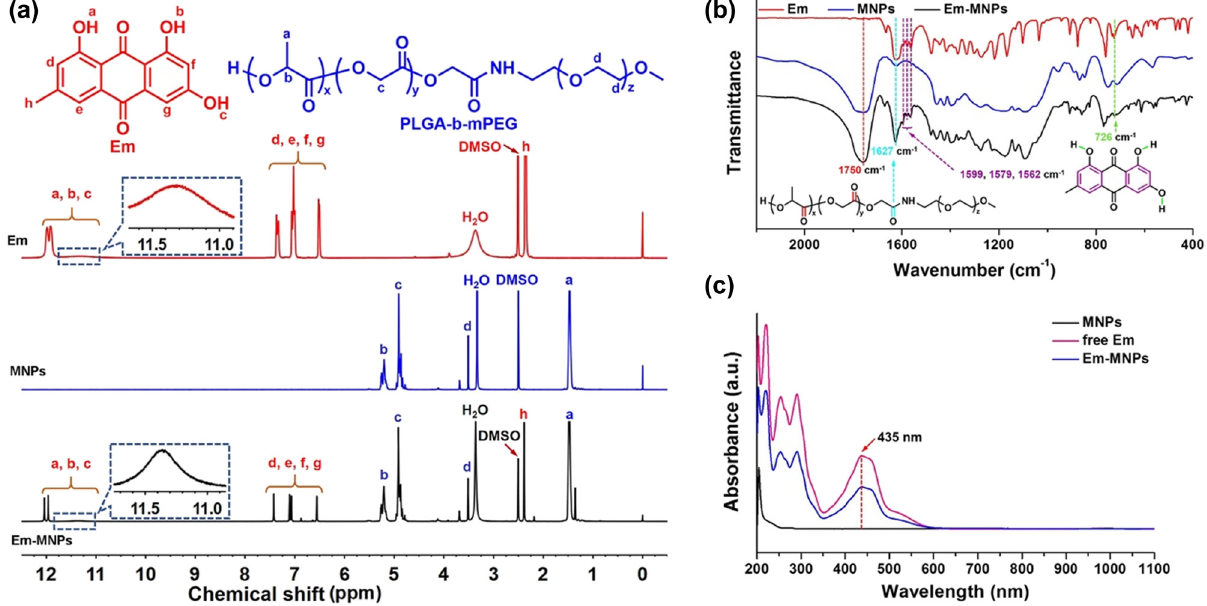
Figure 1: Characterization of MNPs and Em - MNPs. ( a ) 1 H NMP spectra of Em, MNPs, and Em - MNPs. ( b ) FTIR of the Em, MNPs, and Em - MNPs. ( c ) UV - vis spectra of MNPs, free Em, and Em -